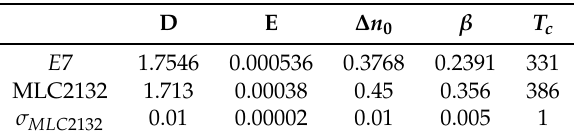
Table 3. E 7 coefficients for the 4-parameter parabolic model [32]. MLC 2132 coefficients for the 4-parameter parabolic model after fitting of the experimental data. The last line indicates the standard deviation of the fitted